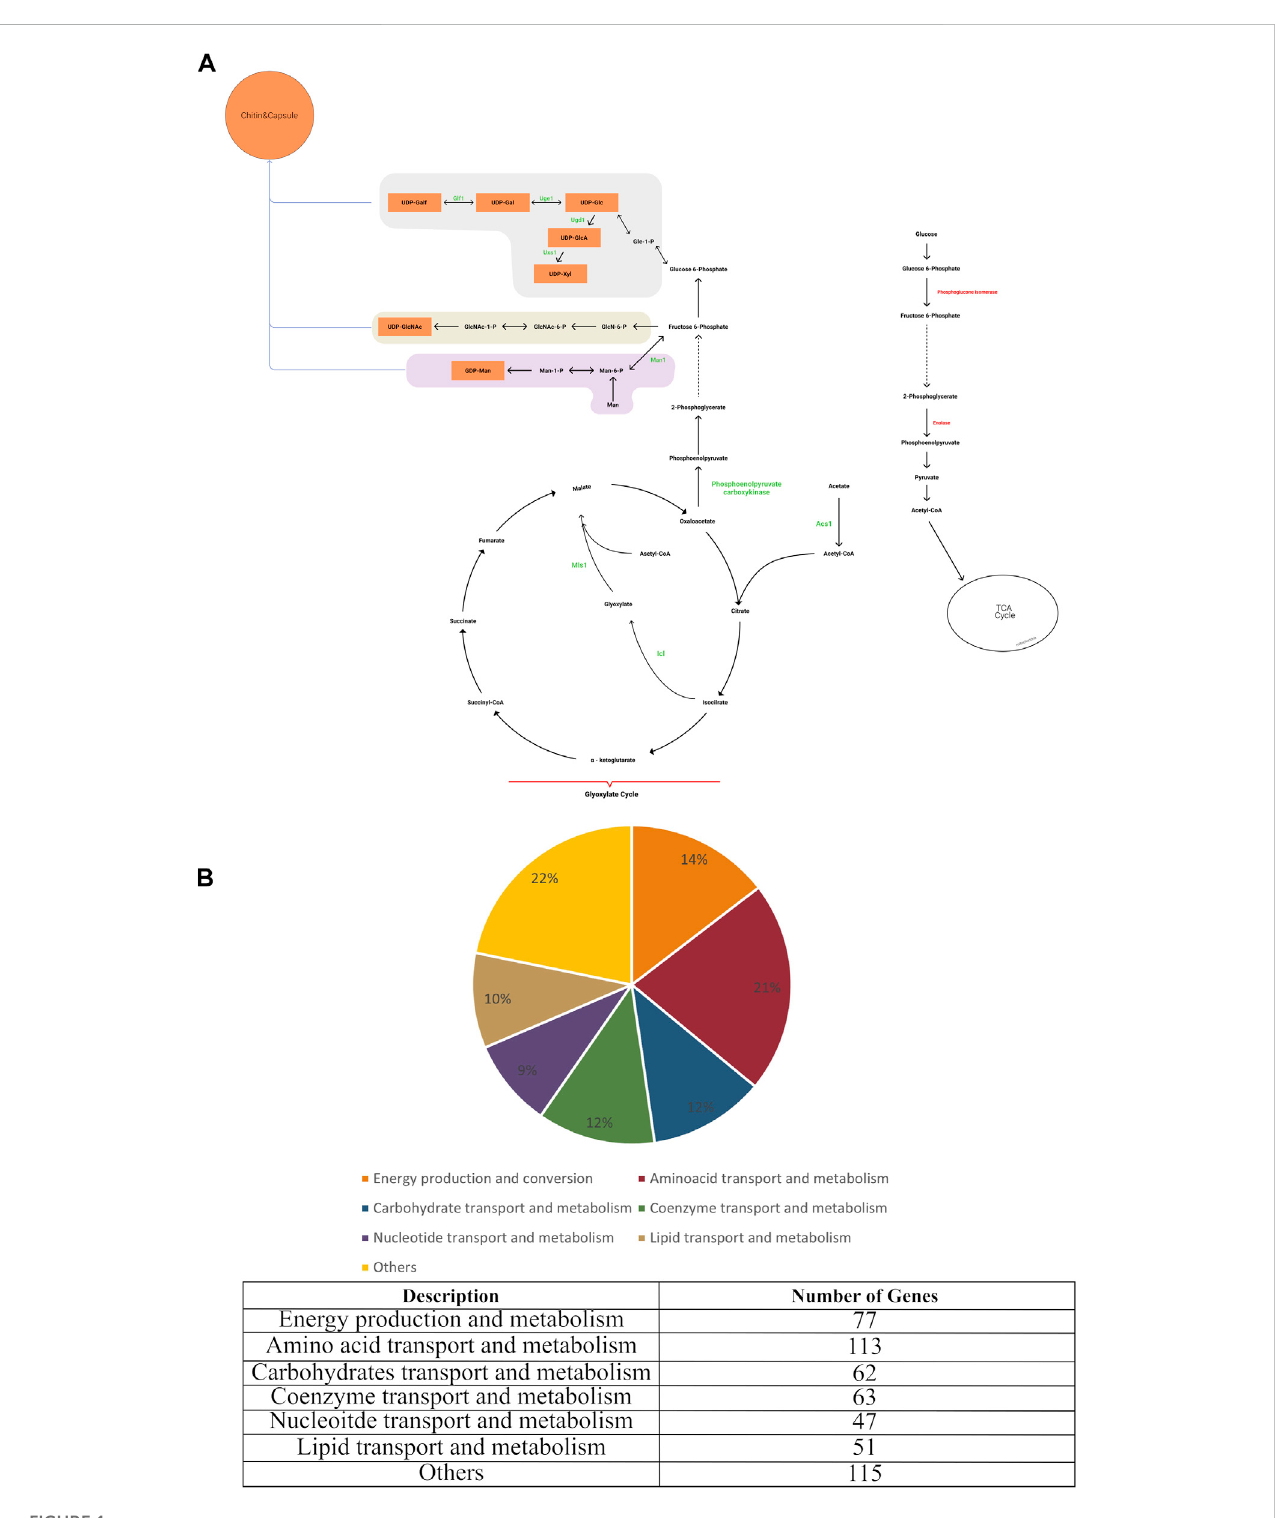
FIGURE 1 (A) Main metabolic reactions in iCryptococcus model including capsule formation, and (B) COG classi fi cation of i Cryptococcus